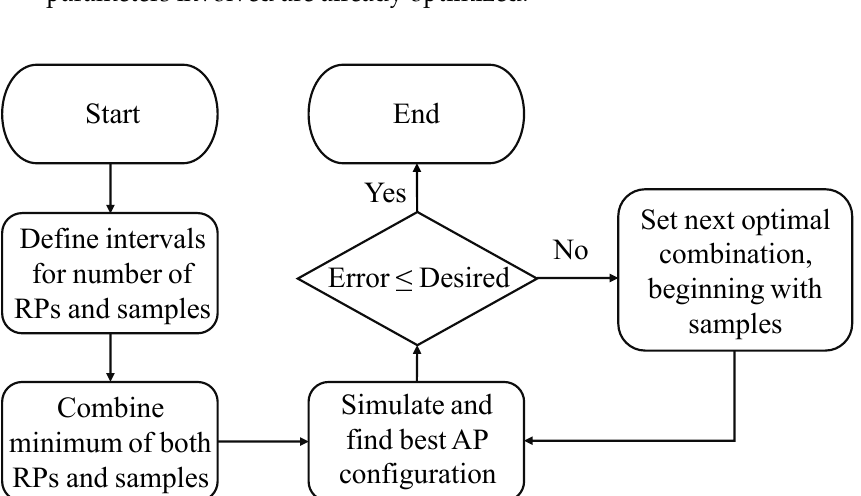
Figure 7. Steps to find the best configuration for a given